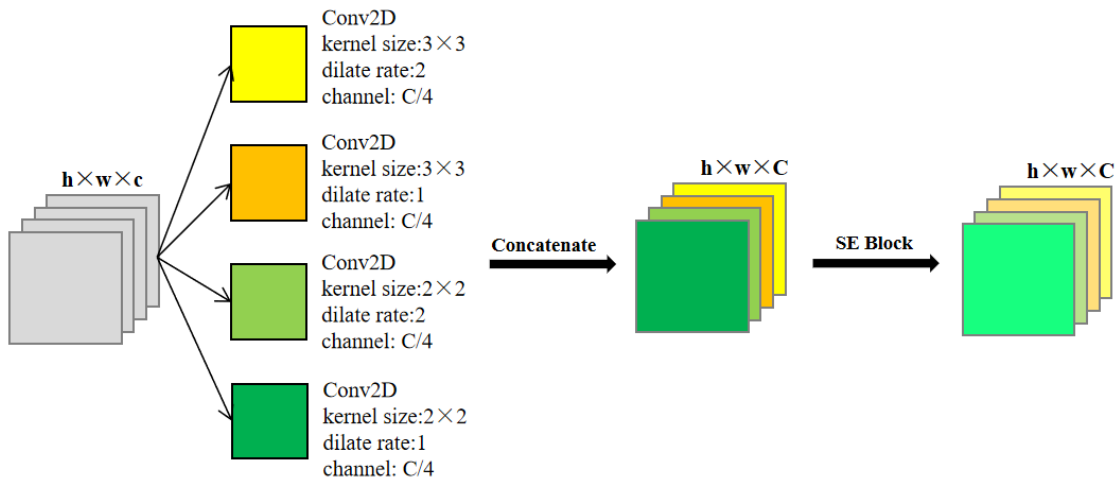
Figure 10. Multi-channel convolution feature selection module structure.